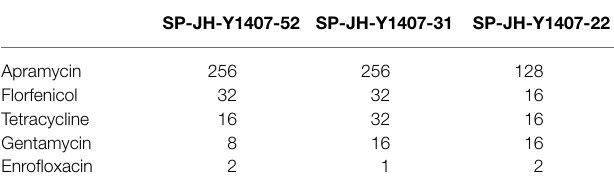
TABLE 2 | MIC values of different drugs on clinical isolates of Salmonella ( μ